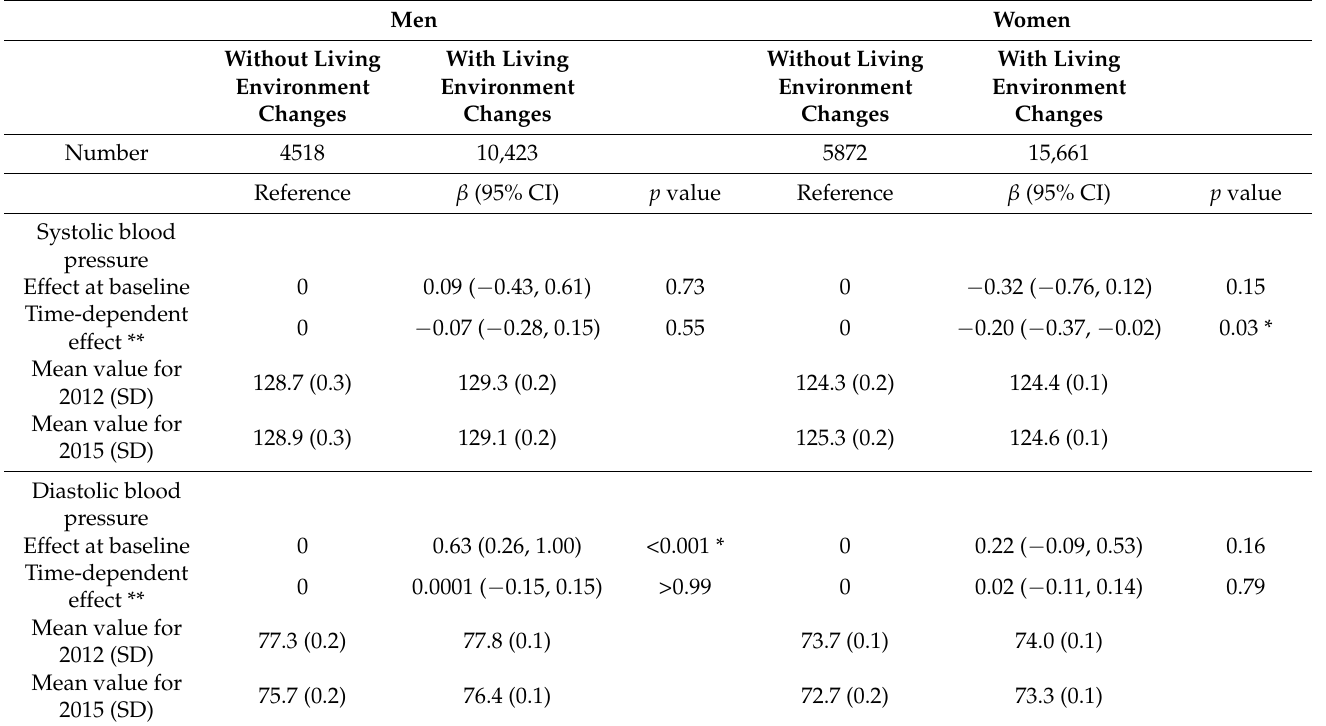
Table 2. Sex-specific changes in systolic and diastolic blood pressures with time by changes in living environment. Men